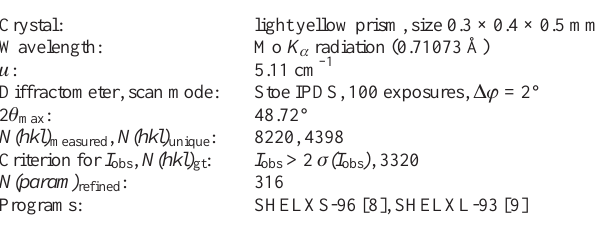
Table 1. Data collection and handling.